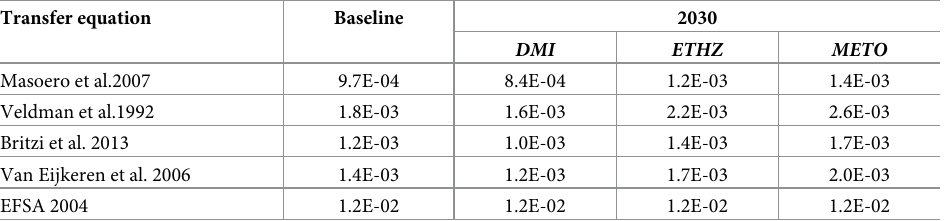
Table 4. Maximum of weekly mean AfM1 concentrations ( μ g/kg) in milk from the whole farm, calculated over 10000 simulations, assuming compound feed contains maize imported from